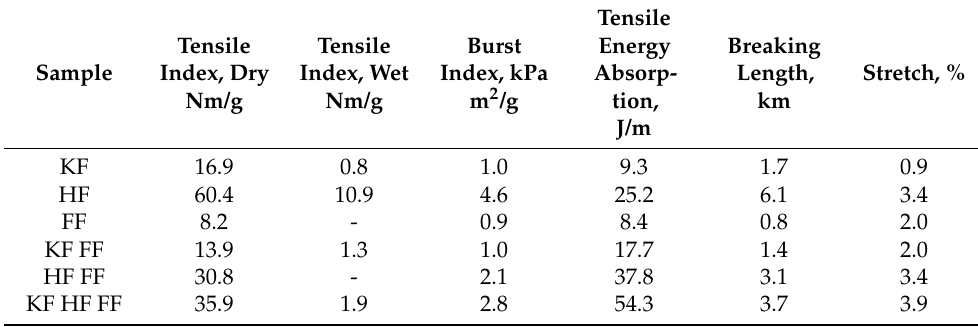
Table 3. Mechanical properties of materials. KF—-kraft fibers, HF—-hemp fibers, and FF—-fungus fibers.